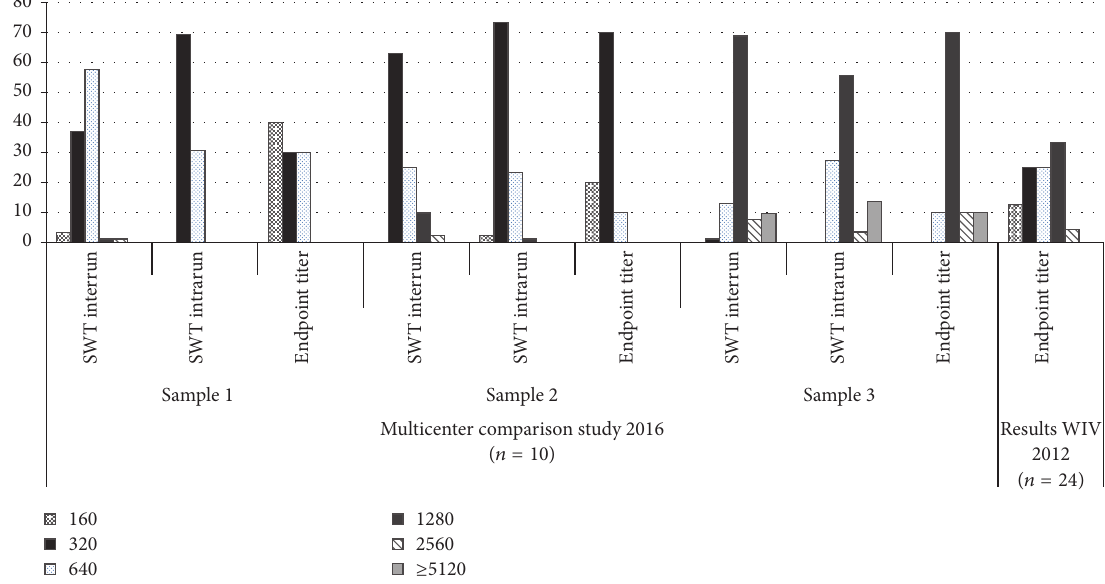
Figure 5: Overview of the reported ANA IIF titers for samples 1, 2, and